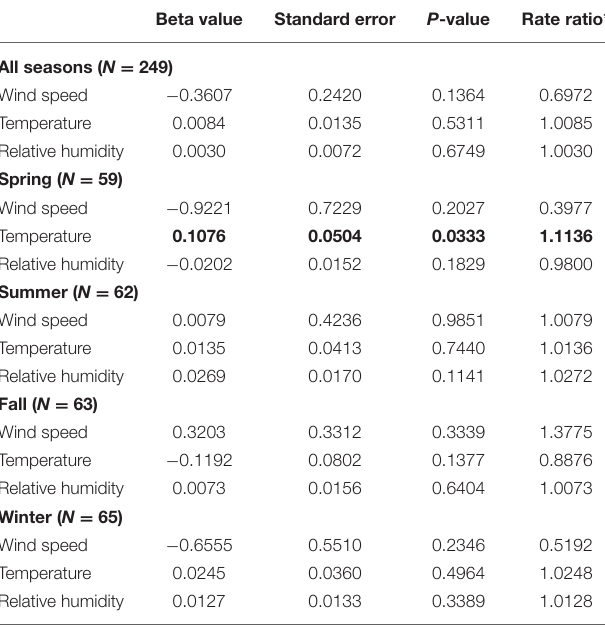
TABLE 2 | The impacts from the changes of weather parameters on the incidence of all CO poisoning.